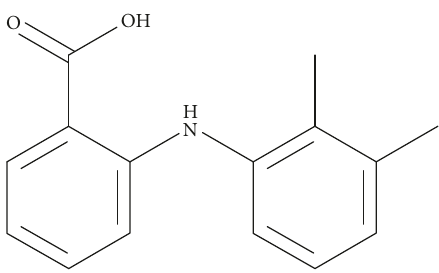
Figure 1: Chemical structure of mefenamic